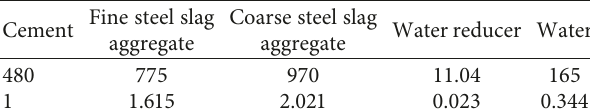
Table 3: Mix ratio of steel slag concrete (kg/m 3